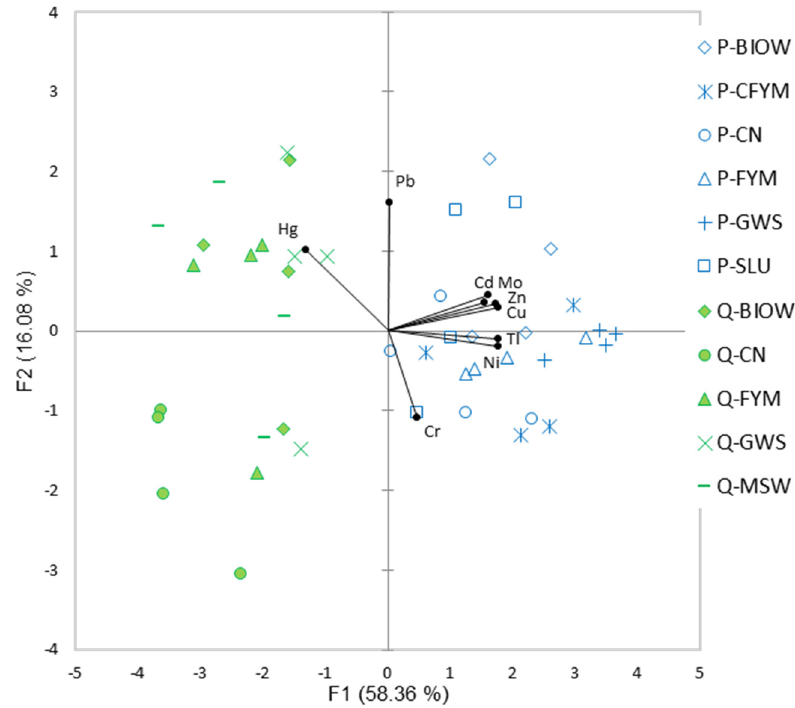
Figure 4. Principal component analysis of soil trace elements concentrations for both sites, after 13–15 years of OWP spreading ( n = 44); see Figures 1 and 2 for treatments signification. At the QualiAgro site, the amounts of OWP applied were 2–2.5 fold higher than at the PROspective site and the initial TE levels were generally lower than at the PROspective site. At this site, cumulated TE inputs by OWP represented up to 15% of the initial soil stock for Cd (Q-MSW and Q-GWS), 48% for Cu (Q-GWS), 32% for Hg (Q-GWS), 8% for Ni (Q-BIOW), 17% for Pb (Q-BIOW) and 26% for Zn (Q-GWS) (Supplementary Materials Table S8). Fifteen years of repeated inputs of OWP did not result in increased concentration